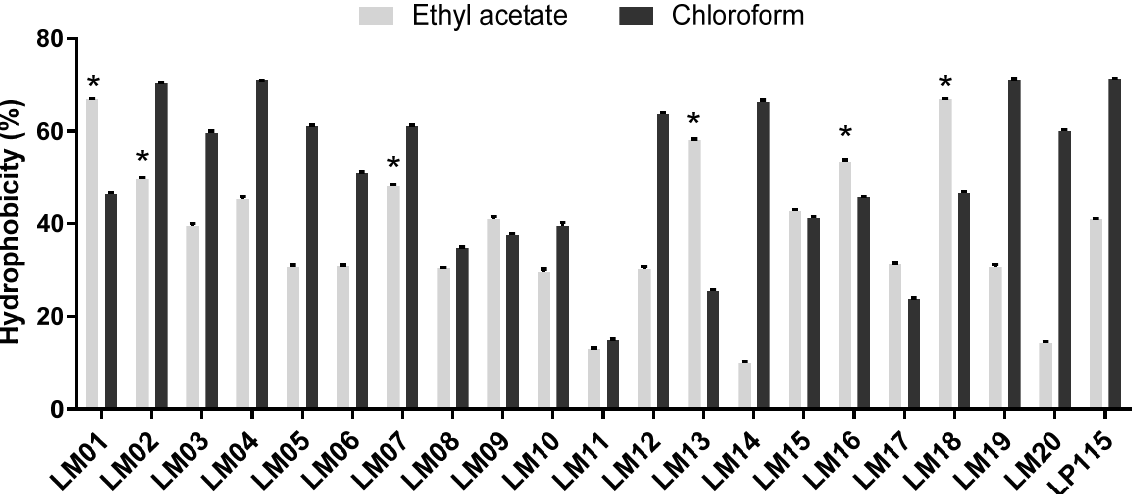
Figure 1. Cell surface properties of lactic acid bacteria (LAB) isolated during fermentation of agave by affinity to solvents. Results are presented by the mean ± SEM; * indicates significant ( p < 0.05) superiority to L. plantarum Lp115 values.